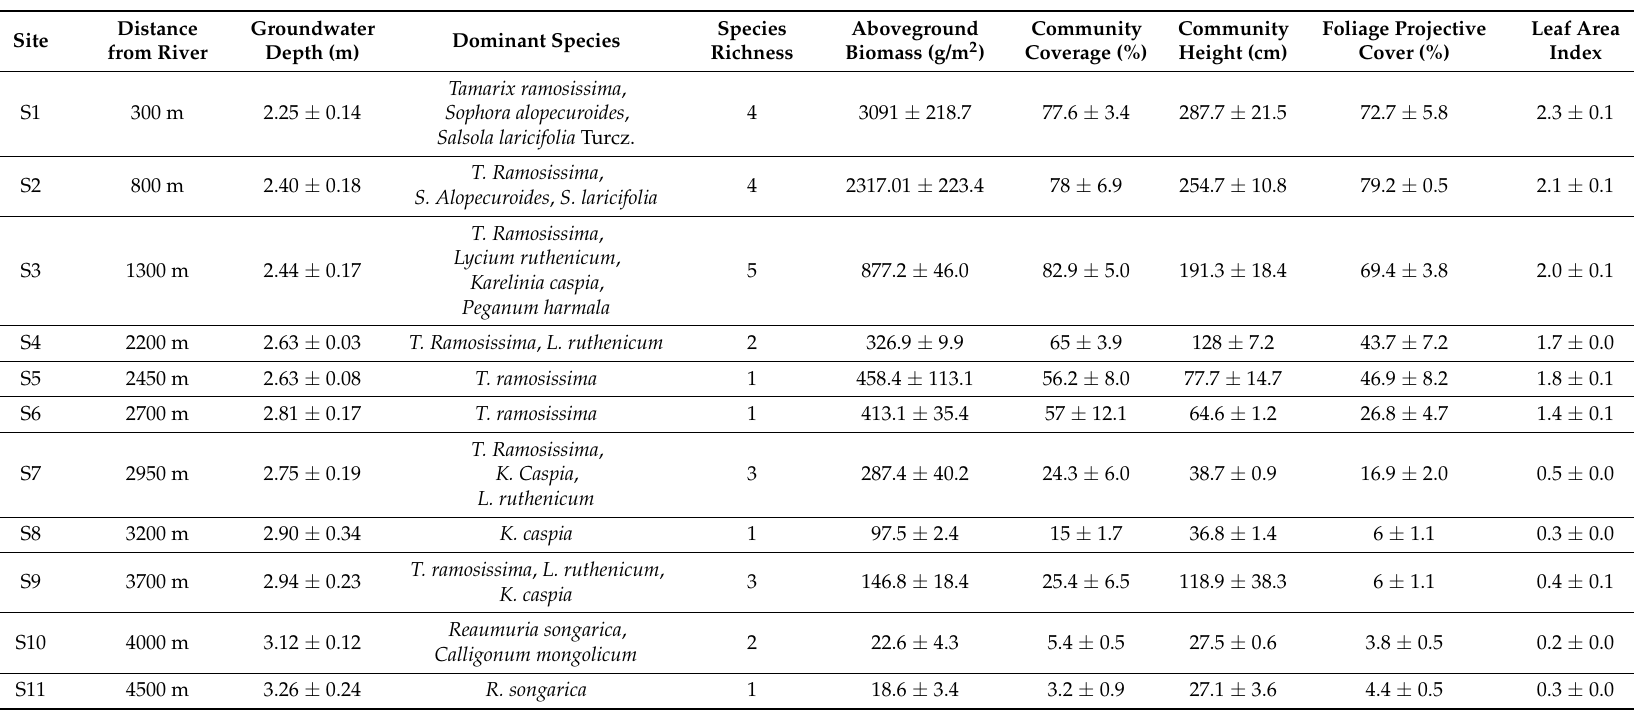
Table 1. Plant community characteristics and mean groundwater depth from the close site to the far site perpendicular to the lower reaches of the Heihe River. Values are means ± SE (Standard Error). The site codes are the same as in Figure